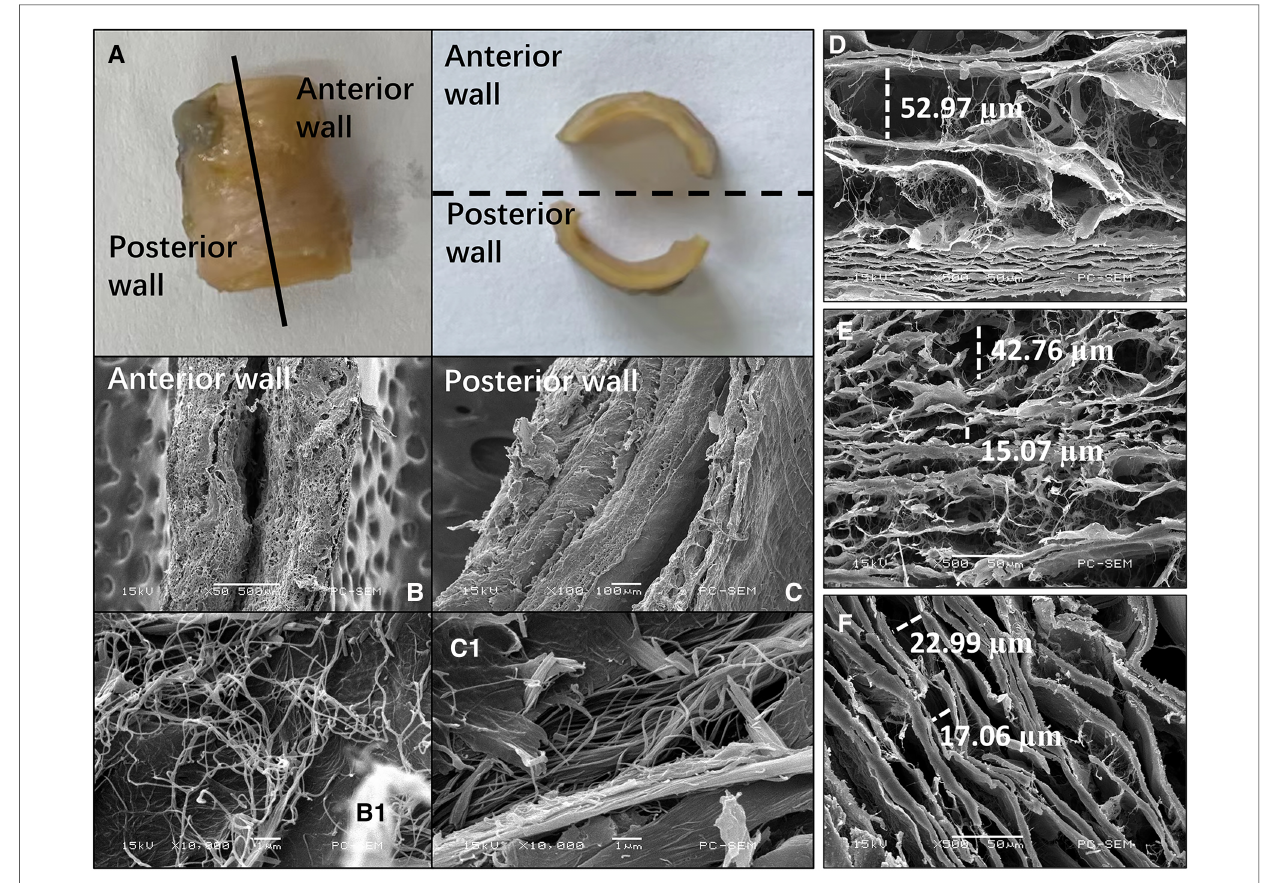
FIGURE 7 Images of the superior mesenteric artery (SMA) wall from an SMA specimen. ( A ) SMA specimen divided into anterior and posterior walls. ( B,C ) Cross- sectional scanning electron microscopy images of the anterior ( B ) and posterior ( C ) wall of the curved segment of the SMA. ( B1, C1 ) Collagen microstructure skeletonization images showing the area between the intima and media of the anterior ( B1 ) and posterior ( C1 ) walls in the curved segment of the SMA. ( D – F ) Scanning electron microscopy images showing the lamellar structure between the intima and media in the root ( D ), curved segment ( E ), and distal segment ( F ) of the SMA. The widths of some gaps have been